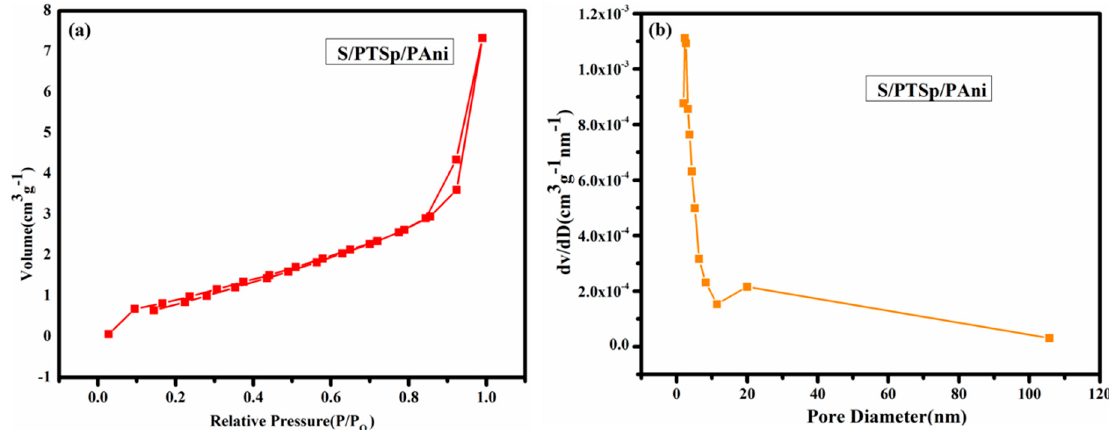
8 of 14 Figure 6. ( a ) Wide spectrum of composite material (sublimed sulfur /post ‐ treated sepiolite/PAni), XPS Spectra of ( b ) oxygen, ( c ) sulfur, ( d ) Nitrogen, ( e ) carbon, ( f ) silicon. 3.6. Nitrogen Adsorption ‐ Desorption Isotherms Figure 7 displays the adsorption ‐ desorption isotherms and density functional theory (DFT) pore size distribution plots of obtained cathode material. Porosity of the composite material was further illustrated by BET adsorption isotherm capacity performed a t 77K using liquid nitrogen. The BET surface area of the as prepared composite material was calculated 5.282 m 2 /g and the pore volume is 0.012 cc/g. In their terms, the type I isotherm appeared in the prepared material through the